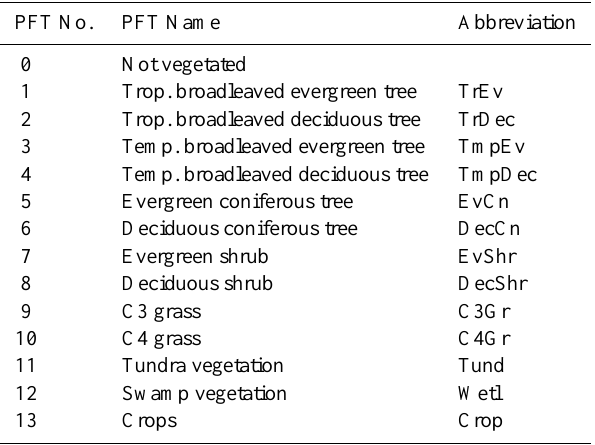
abbreviations, taken from Rayner et al. (2005).